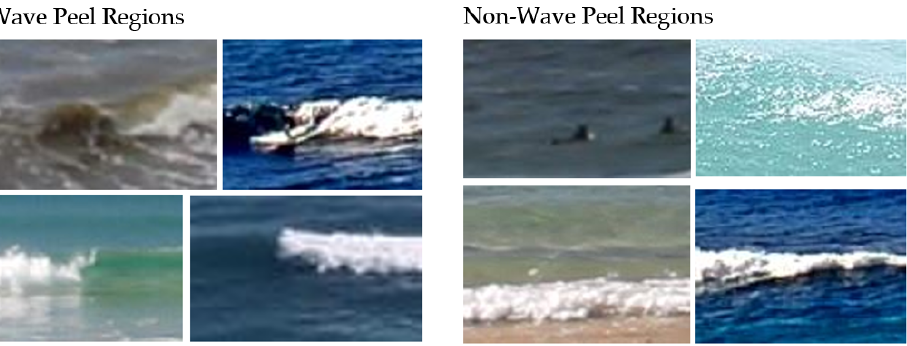
Figure A1. Examples of labelled classification images as used for training. Labelled images did not need to be very high resolution.